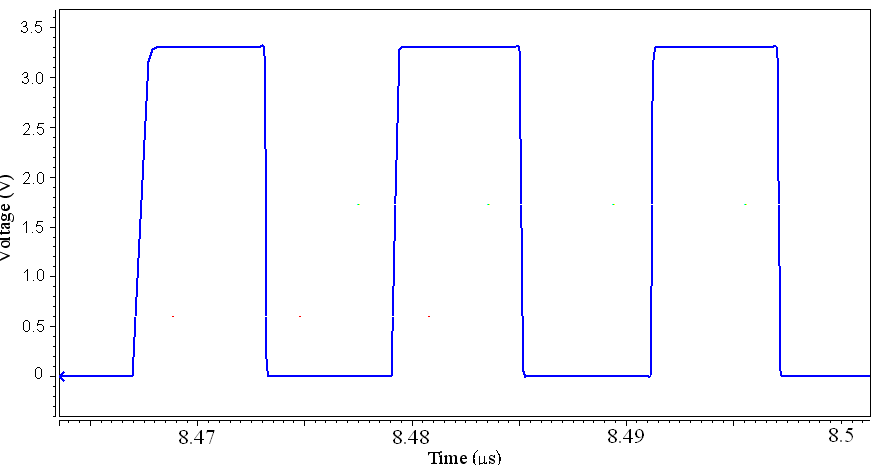
Figure 4. Output signal of the